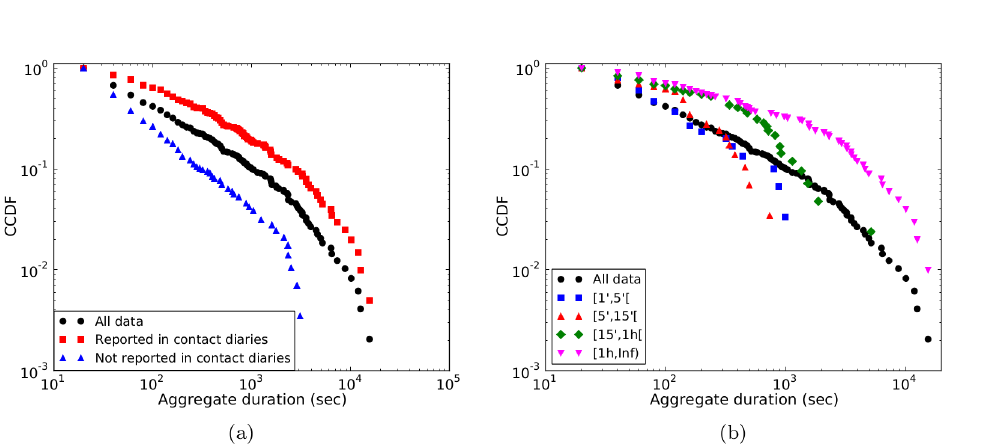
Fig 3. Contact matrices of link densities. We compare here the contact matrices of link densities built from (a) the network of contacts obtained using the sensor data collected on Dec. 5 th and (b) the network of contacts as reported in the contact diaries. We discarded here the data corresponding to the MP * 1, PC * and PSI * classes as too few students from these classes filled in a contact diary (2 for MP * 1, 0 for PC * and PSI * ). The similarity between these two matrices is of 97%.